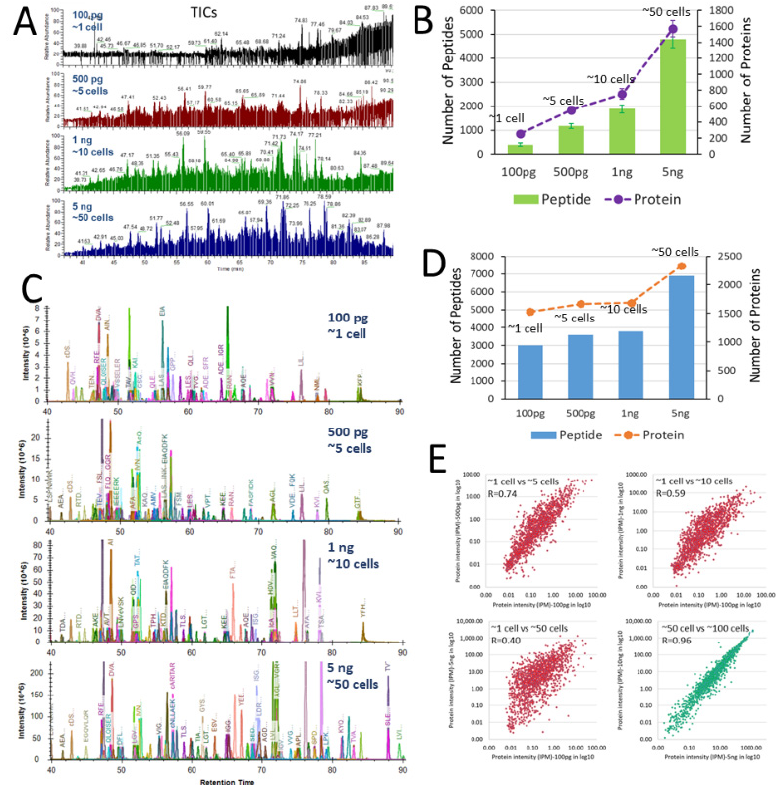
Figure 3. Assessment of single-cell analysis using SLB-SCP platform. ( A ) The raw total ion chromatograms (TICs) of HeLa cell digests for pseudo samples of a single cell (100 pg), 5 cells (500 pg), 10 cells (1 ng), and 50 cells (5 ng). ( B ) Number of unique peptides and proteins identified in the HeLa cell digests with 1% error rate according to a database search. ( C ) Extracted ion chromatograms (EICs) of the HeLa cell digests with SLB-SCP using the spectral library generated from the bulk scale analysis. ( D ) Number of unique peptides and proteins identified in all three replicates of the HeLa cell digests using SLB-SCP with stringent criteria (error rate: 1%, E-value ≤ 0.001, FDR < 0.001, idotp ≥ 0.5, IPM ≥ 0.01). ( E ) Correlations of the protein abundances of pseudo single-cell with pseudo 5, 10, and 50 cells (red plots), and correlation of the protein abundances of pseudo 50 cells with pseudo 100 cells (green plot). The data showed a non-linear dynamic range in protein abundances measured in the pseudo single cell in correlation with the bulk scale analysis. The plots are in log10 scale.